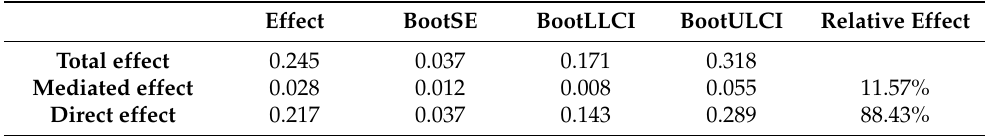
Table A1. Decomposition table for total, direct, and mediated effects.